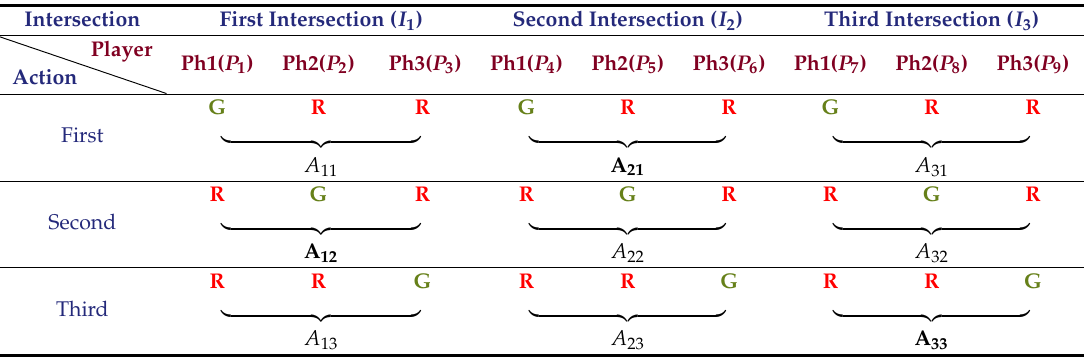
Table 2. Multi-player matrix